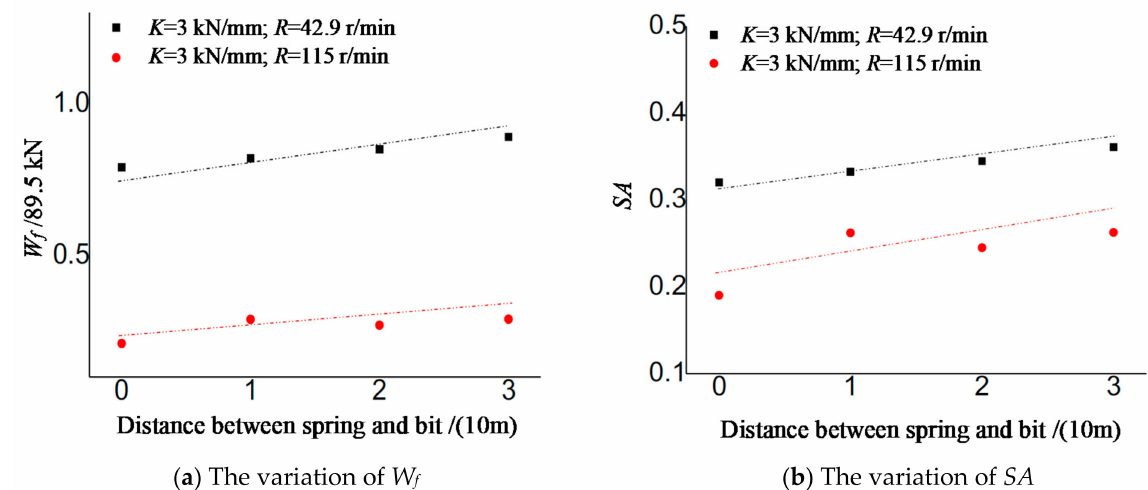
Figure 11. The variation of W f and SA with the distance between spring and bit.